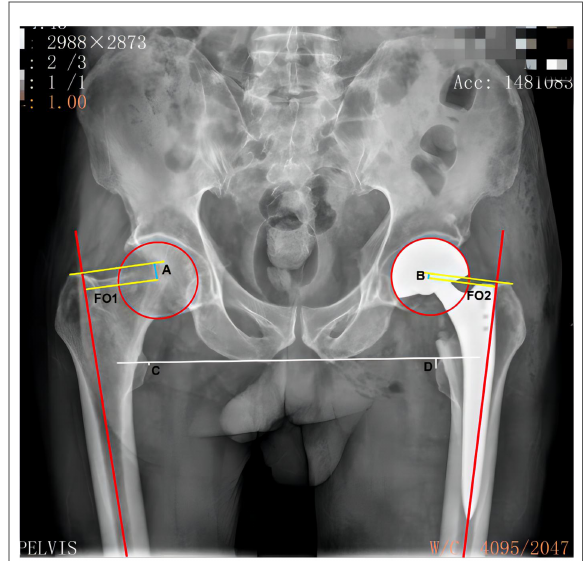
FIGURE 2 X-ray. (A) the vertical distance from the center of the femoral head to the tip of the greater trochanter on the anatomical axis of the femur on the non-operative side. (B) the vertical distance from the center of the femoral head to the tip of the greater trochanter on the anatomical axis of the femur after surgery on the operative side. (C), the vertical distance from the tip of the lesser trochanter to the connected line of the bilateral sciatic tuberosity after surgery on the non-operative side. (D) the vertical distance from the tip of the lesser trochanter to the connected line of bilateral sciatic tuberosity after surgery on the operative side. The LLD is the difference between the measured values of both sides. FO 1: the distance between the center of rotation of the femoral head and the long axis of the femur on the non- operative side. FO 2: the distance between the center of rotation of the femoral head and the long axis of the femur after surgery on the operative side. The difference between the measured values of the two sides is the FO difference. LLD, leg length discrepancy; FO, femoral